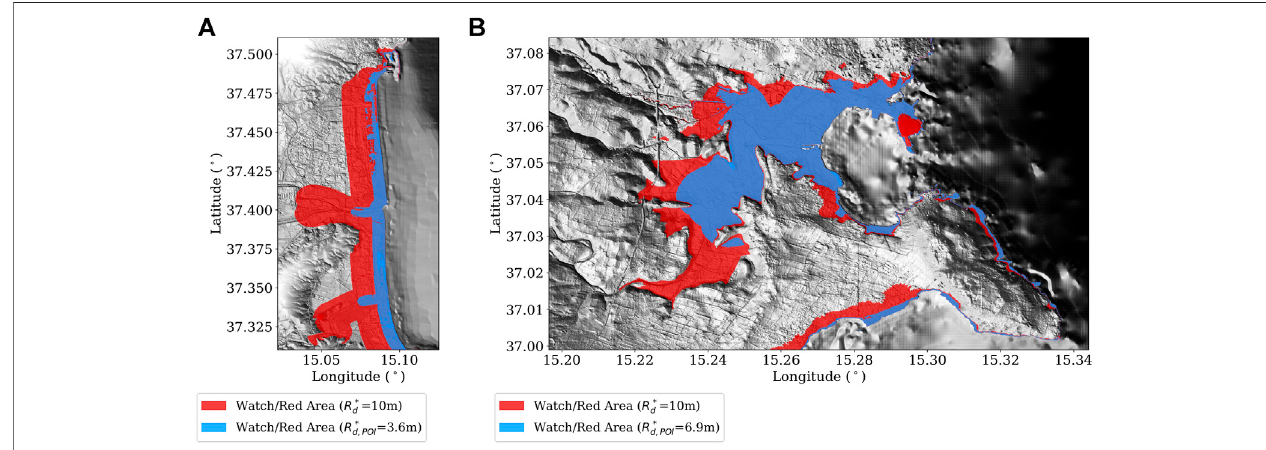
FIGURE 7 | Comparison between the Watch/Red areas designed for R p d (cid:1) 10m (the gray area in Figures 5C, 6C ) and the inundation maps obtained using the values obtained from the POIs in front of Catania [panel (A) ] and Siracusa [panel (B) ].